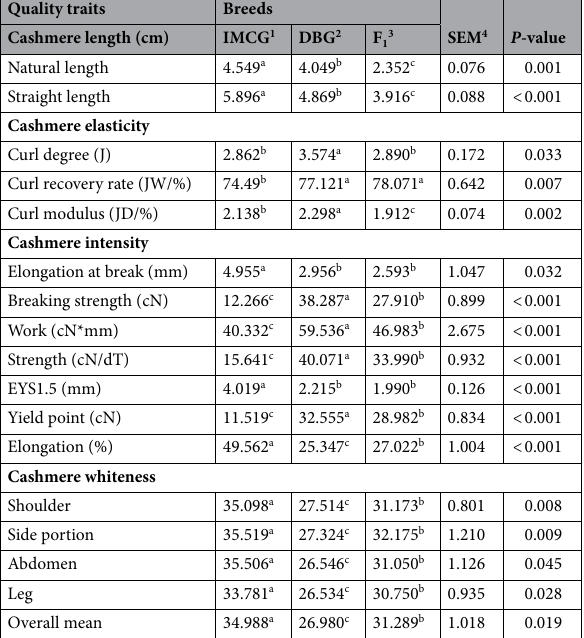
Table 3. Quality traits of cashmere fibre of IMCG 1 , DBG 2 and their first cross F 1 3 (mean ± SEM). 1 IMCG